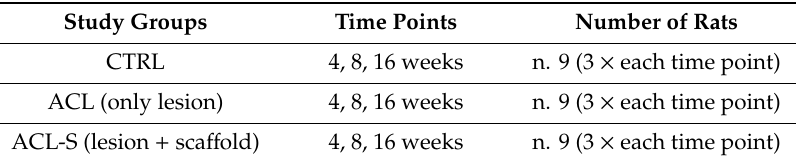
Table 1. The ACL groups consisted of rats submitted to surgical treatment to create defects inducing the ACL model. In the CTRL group, only 4-week samples were taken into account for the analysis. Table 1. Experimental groups. Study Groups Time Points Number of Rats CTRL 4, 8, 16 weeks n. 9 (3 × each time point) ACL (only lesion) 4, 8, 16 weeks n. 9 (3 × each time point) ACL-S (lesion + sca ff old) 4, 8, 16 weeks n. 9 (3 × each time